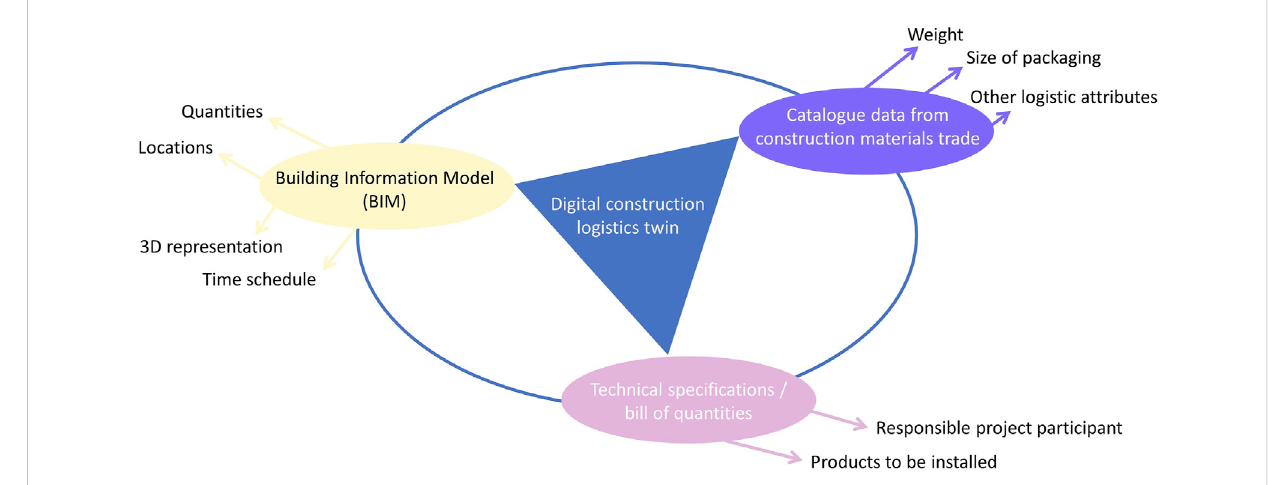
FIGURE 5 Data sources for the digital construction logistics